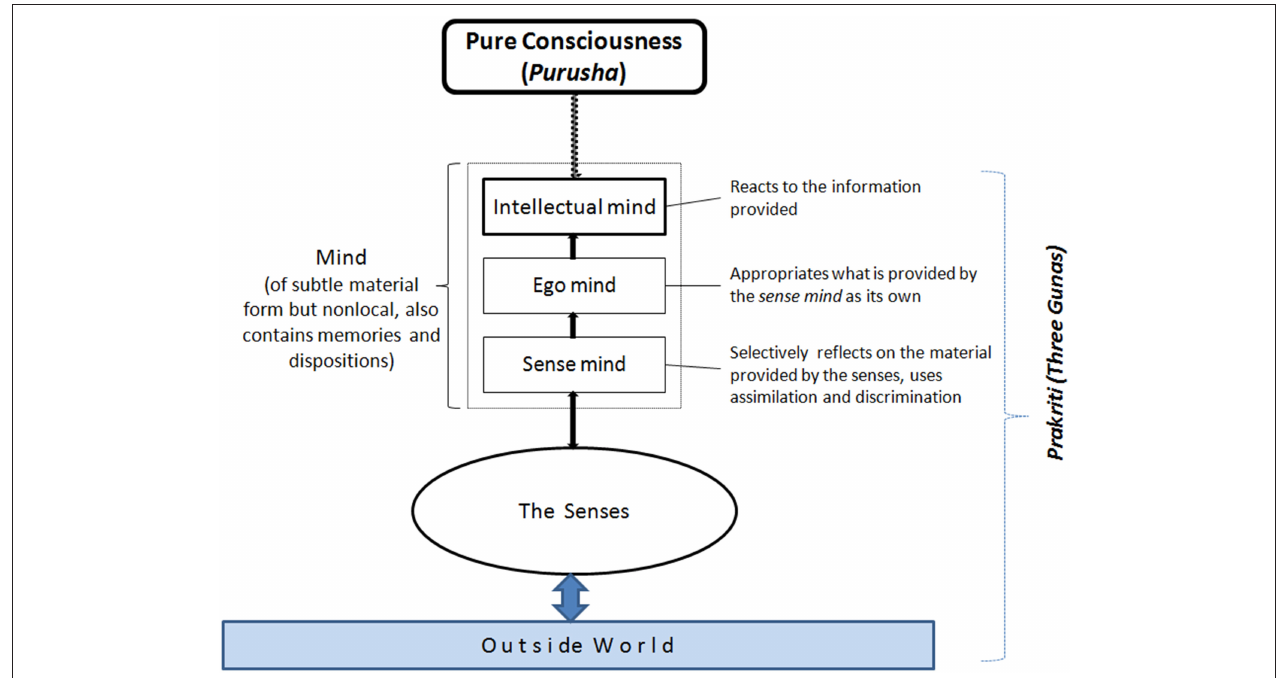
FIGURE 1 | Graphic description of how cognition works according to